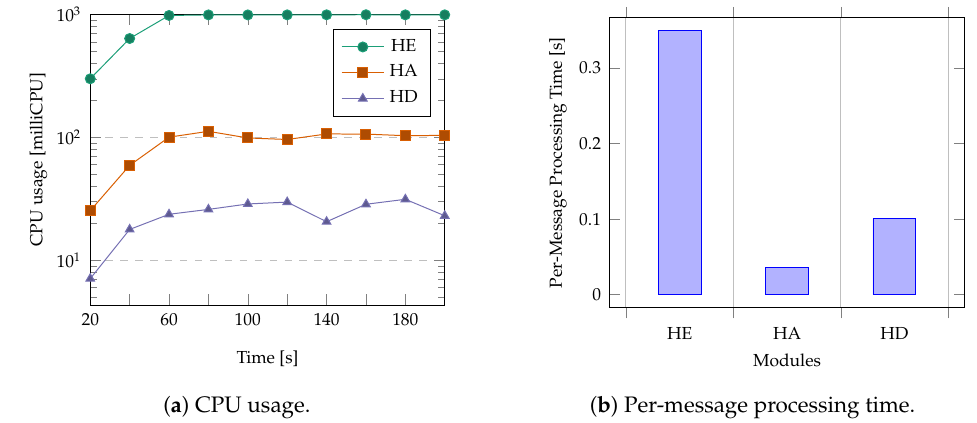
Figure 6. eINP modules performing homomorphic encryption, averaging, and